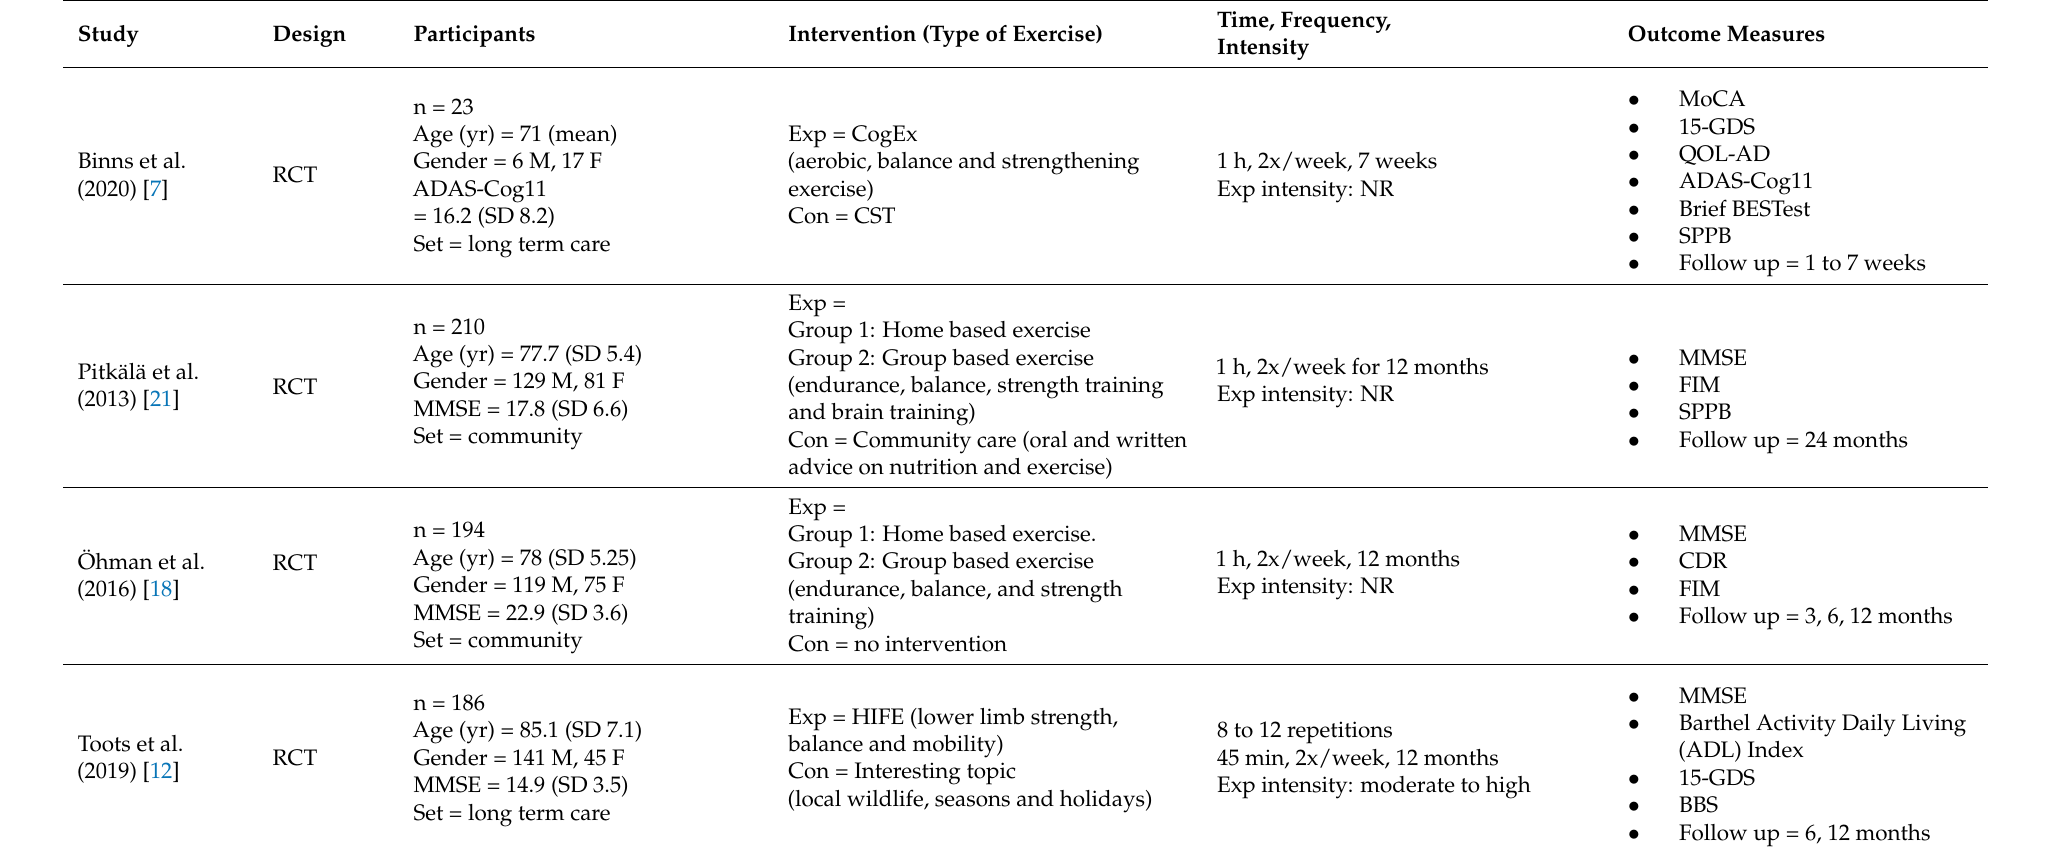
Table 2. Summary of included